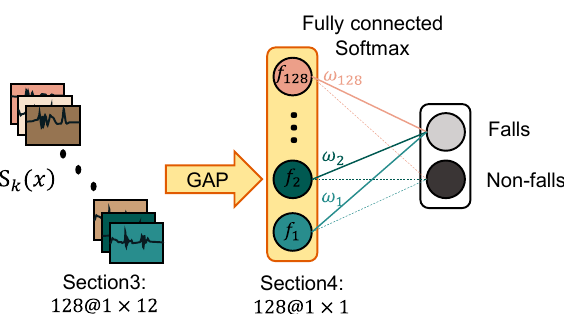
Figure 4. The network architecture that can apply the CAM method. The key layer is the global average pooling (GAP) layer, which establishes the mapping relationship between feature maps and classes. S k ( x ) represents the output sequence of the last convolutional layer on the channel k. f k is the output of channel k after the GAP. ω c represents the weight of the features of each channel, k, to di ff erent class, c. For visualization, the importance of the data contributing to fall detection was normalized and mapped to the range of [0,255]. In this way, the importance from low to high can be expressed as a color bar from purple to yellow. The length of the time series after three-layer convolution and pooling is generally inconsistent with the length of the original data input. To visualize the areas in the original data that contribute to the fall detection, the class activation map was upsampled, and the color